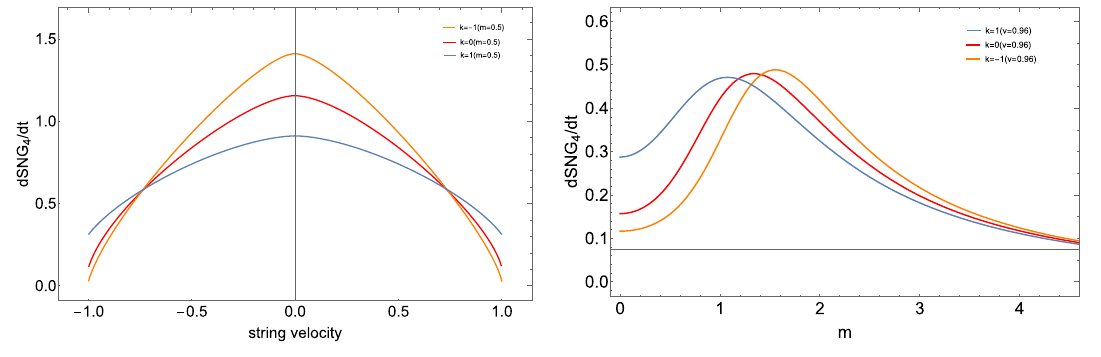
Fig. 9 Action growth for massive AdS 4 black hole. Left: action growth v.s. string velocity with m = 0 . 5. Right: action growth v.s. graviton mass with v = 0 . 96. Here we have set black hole mass m 0 =